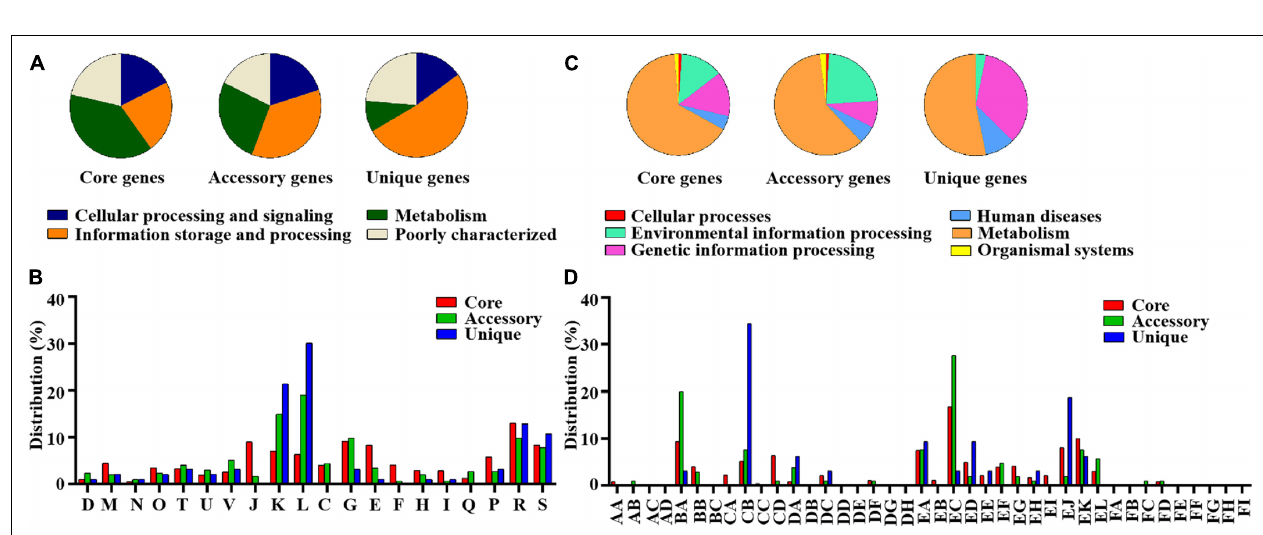
FIGURE 6 | Pan-genome of 12 Streptococcus dysgalactiae subsp. dysgalactiae (SDSD) isolates. The pan-genome of 12 SDSD tested in this study had 2,663 genes; the size of the genome in the pan-genome continued to increase as the number of strains increased. However, the number of core genomes (shared by 100% of SDSD isolates) was fairly constant at ∼ 1,600 genes.